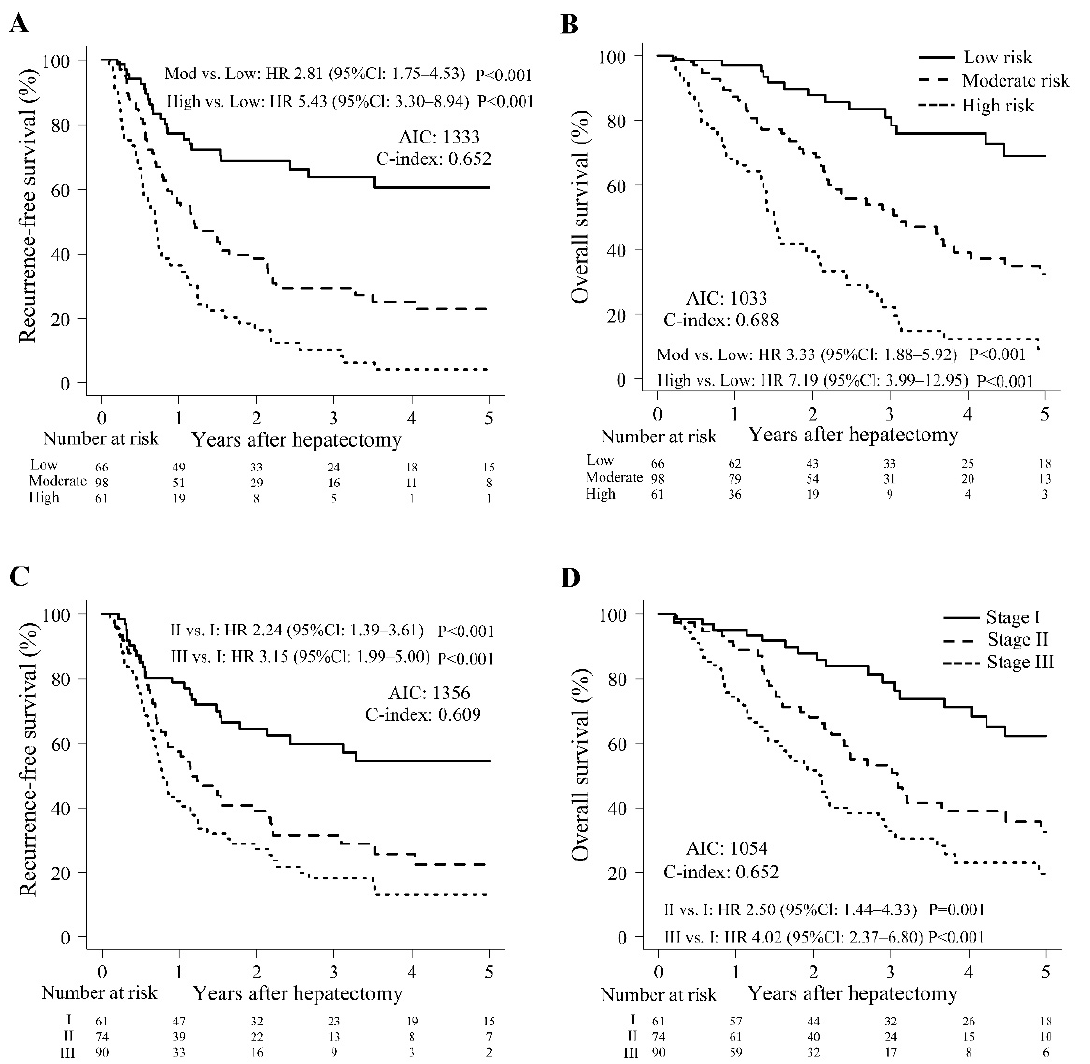
Figure 2. Survival outcomes. ( A ) Recurrence-free survival among three groups stratified according to the three risk classifications. ( B ) Overall survival among three groups stratified according to the three risk classifications. ( C ) Recurrence-free survival among three groups stratified according to the 8th edition of the AJCC staging system. ( D ) Overall survival among three groups stratified according to the 8th edition of the AJCC staging system. CI: confidence interval; HR: hepatic resection; AIC: Akaike information criterion.